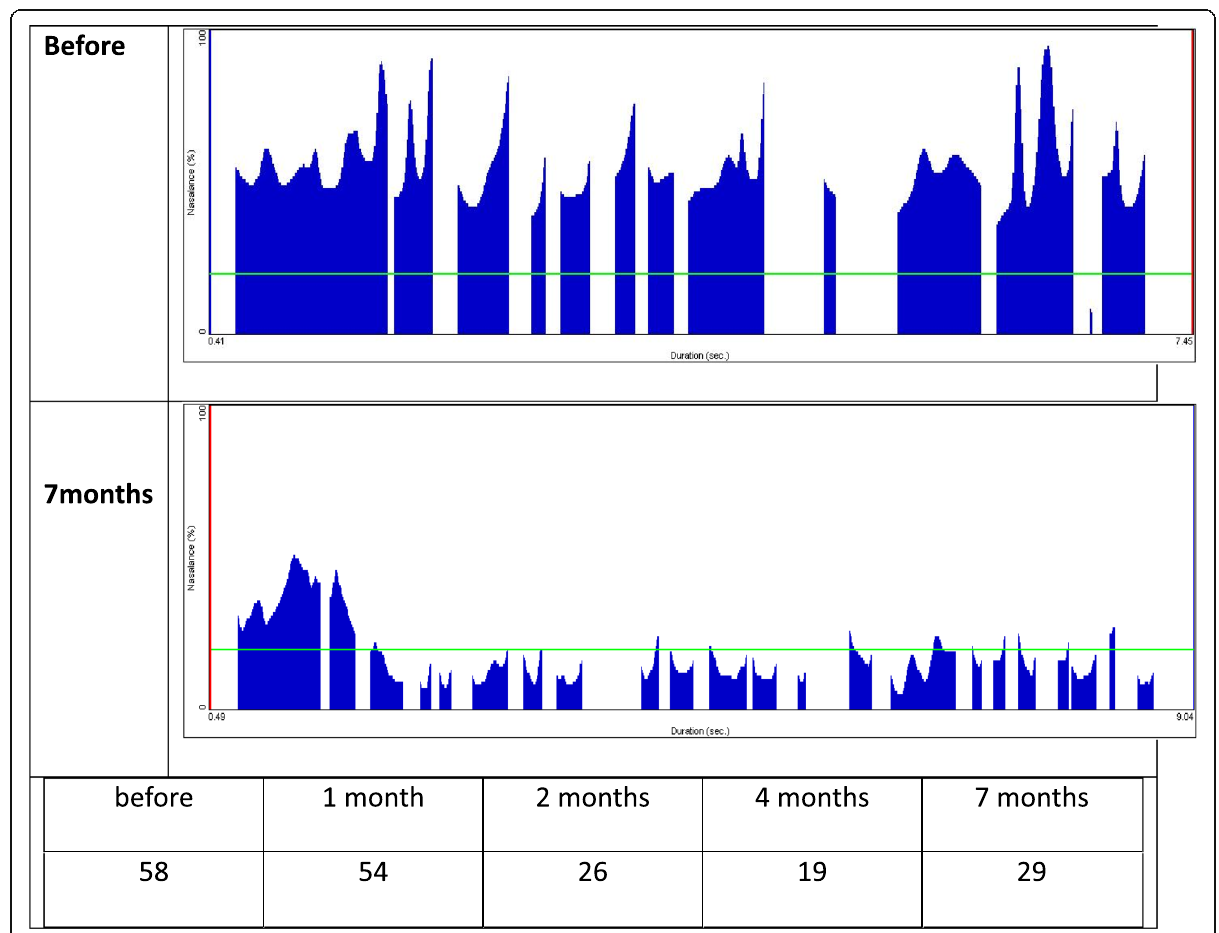
Fig. 6 Evaluation of hypernasality (sentence). Measurements of nasal emission energy in “ nasal consonant ratio (NCR) 0% sentence ” using nasometer. Nasalance percentages less than or equal to 20% are considered to represent the absence of nasality and are marked with a green line. The nasality was significantly decreased when compared with 7 months after